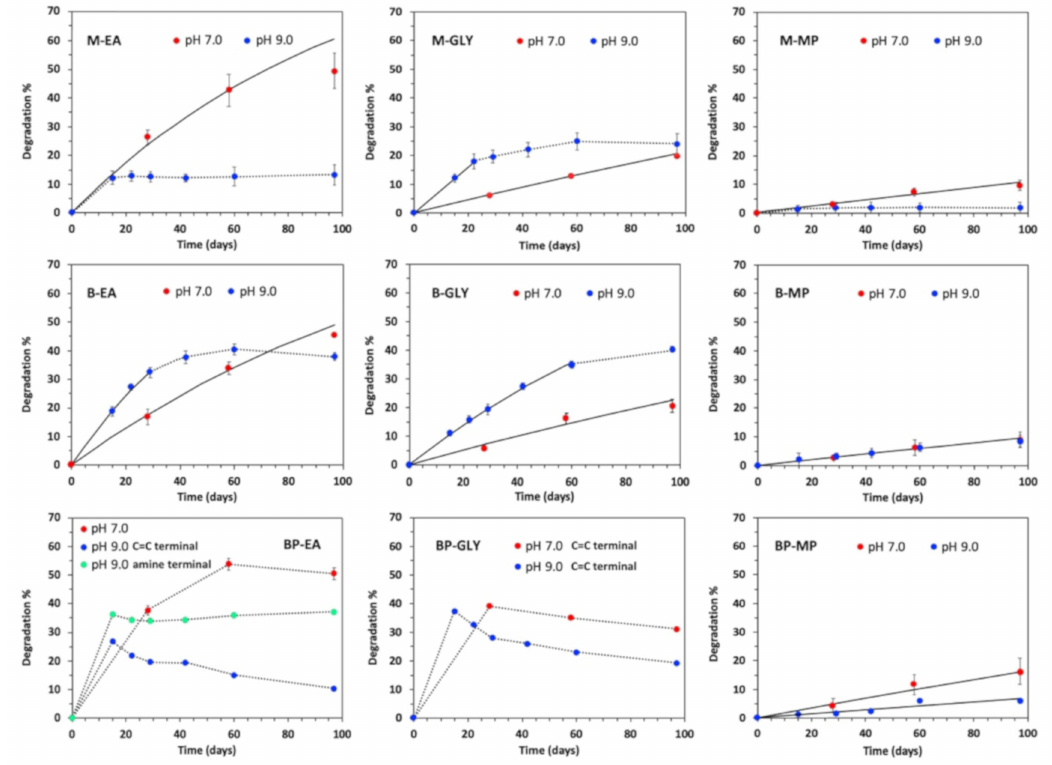
Figure 7. Comparison of the degradation behavior of linear PAAs at pH 7.0 and